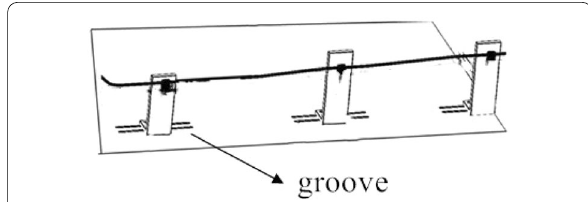
Figure 6 Schematic diagram of the movable clamp position and groove